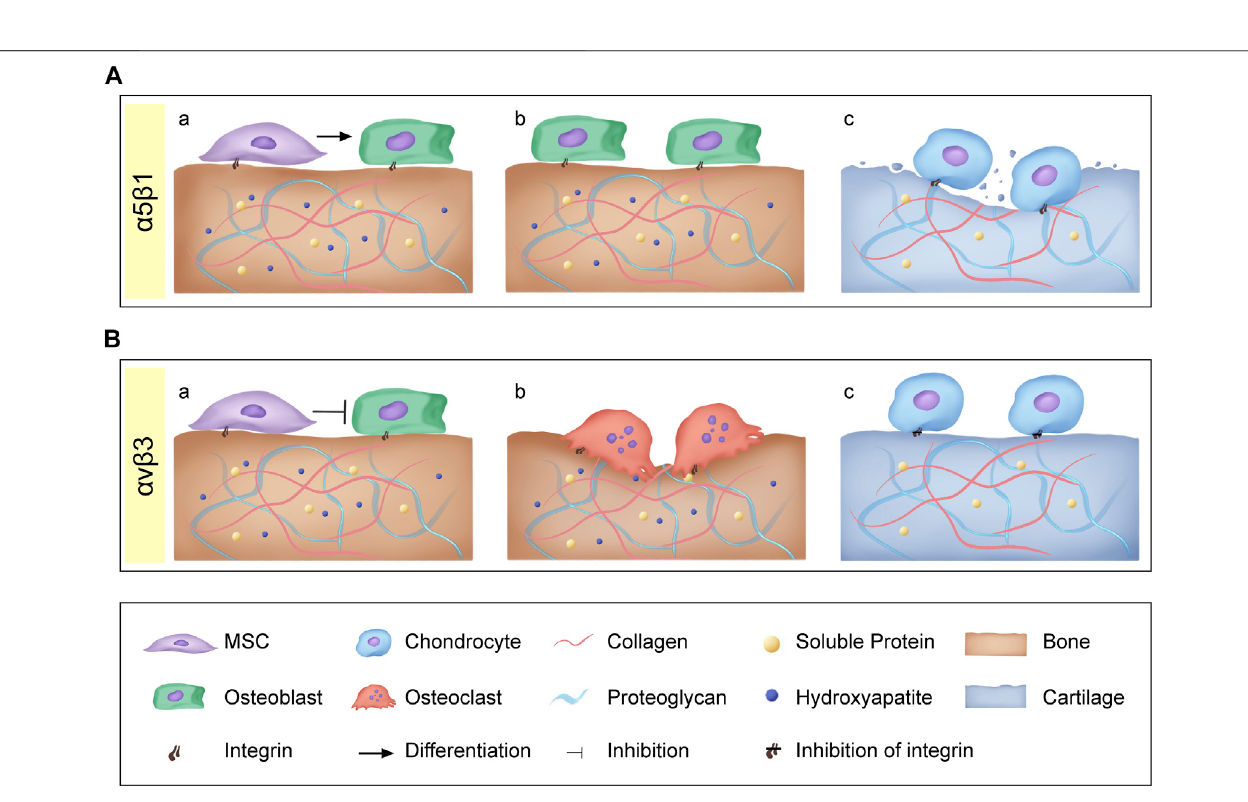
osteoblast survival and bone mineralization. Inhibiting the expression of α 5 β 1 will lead to a low osteoblast survival rate (Dufour et al., 2008) and bone loss (Schneider et al., 2001; Dufour